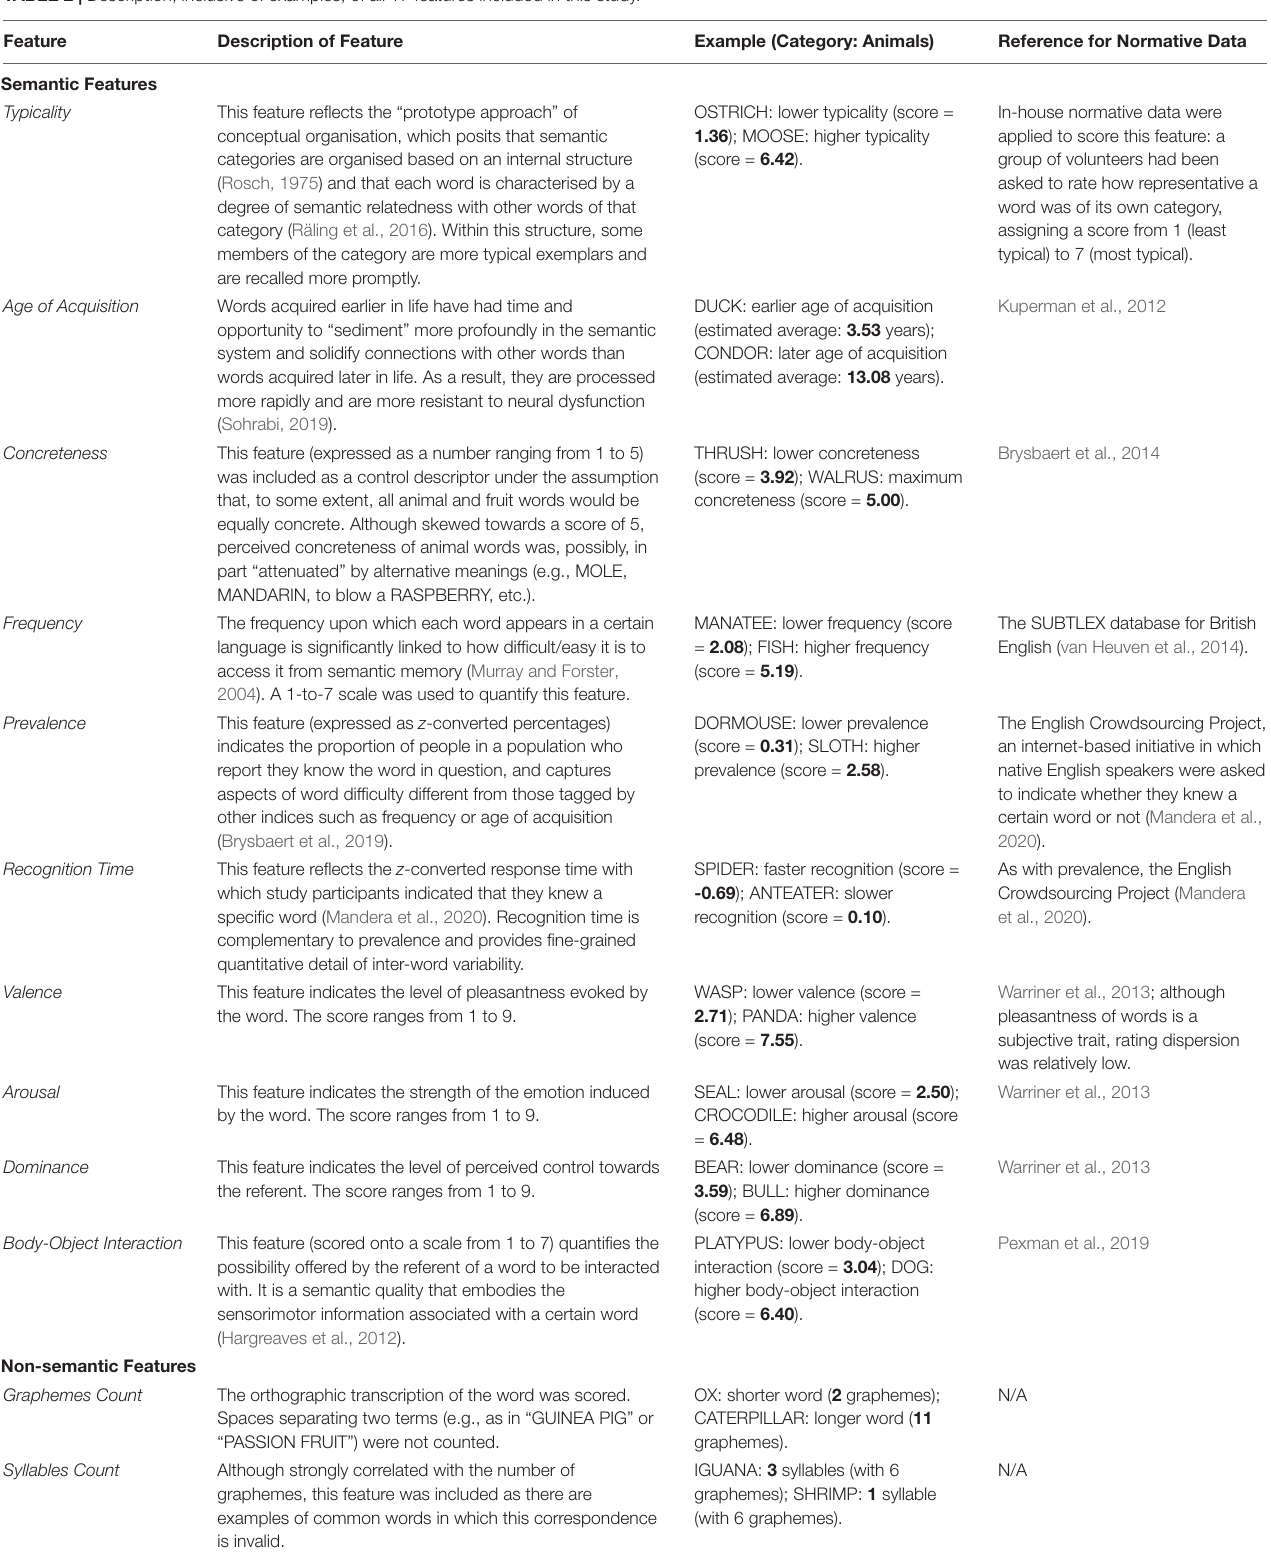
TABLE 2 | Description, inclusive of examples, of all 17 features included in this